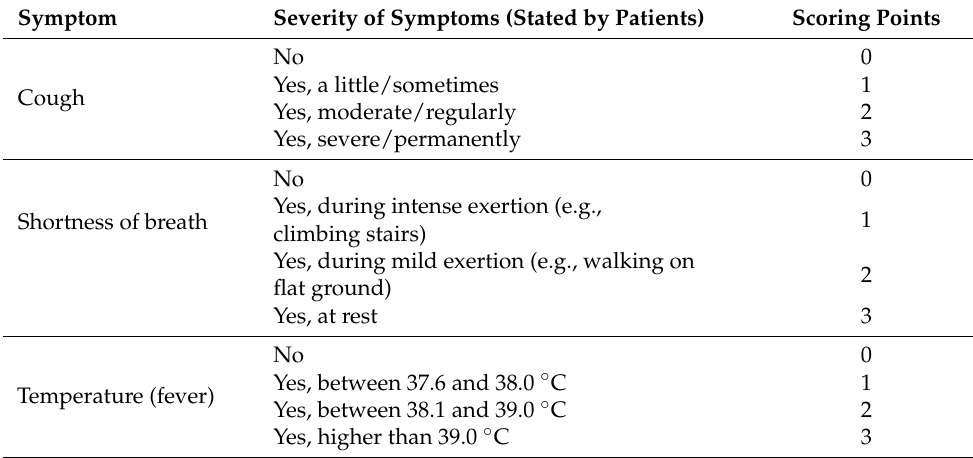
Table 1. Severity of symptoms and scoring points used for the symptom-based score [7]. Symptom Severity of Symptoms (Stated by Patients) Scoring